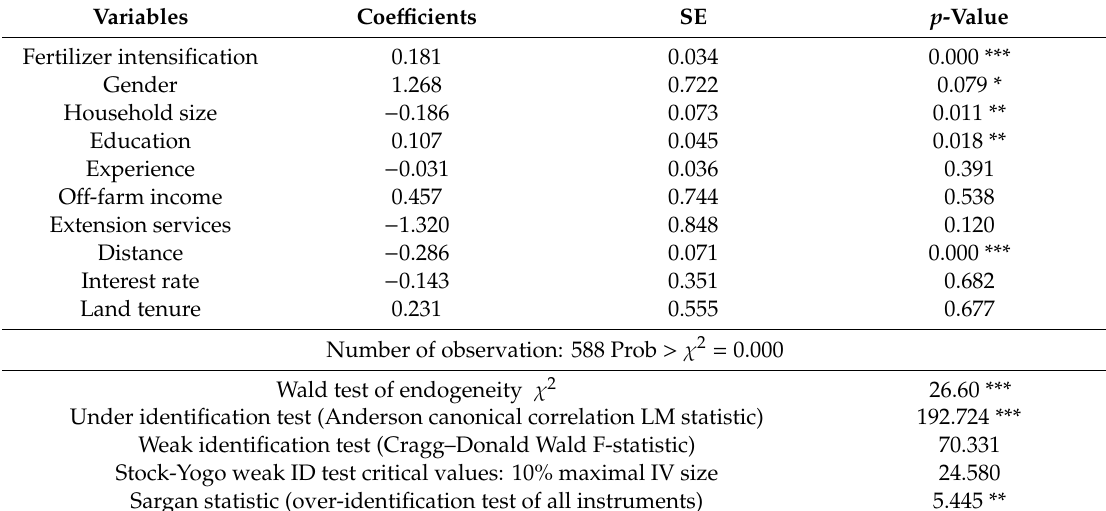
Table 3. Estimates for the dependent variable access to credit (AC):